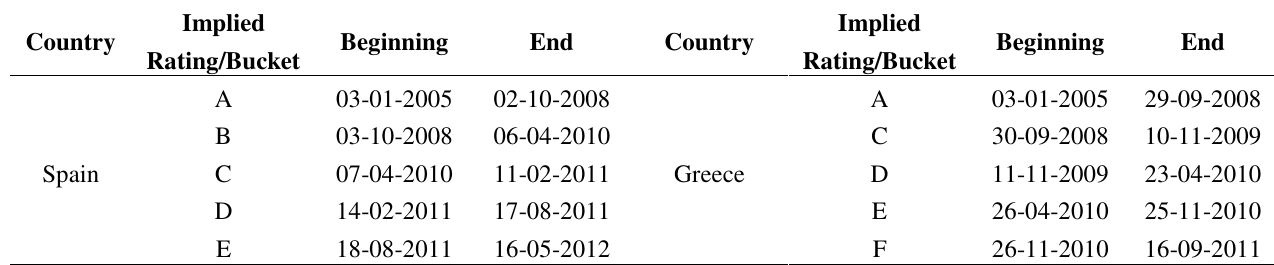
Table 2. Implied